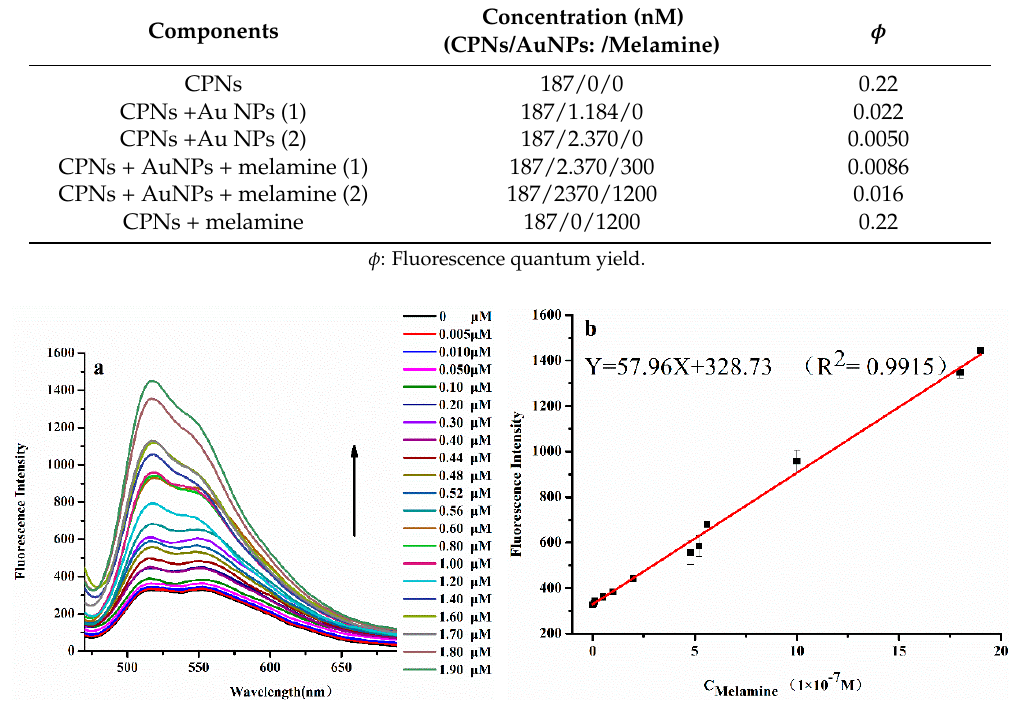
Figure 6. ( a ) Fluorescence emission spectra of CPNs-AuNPs nanosensor with different concentrations of melamine from 0.05 to 19 × 10 − 7 mol/L. CPNs: 0.187 μ M. AuNPs: 2.37 nM; ( b ) a linear relationship with respect to the enhanced fluorescence intensities and melamine concentrations.